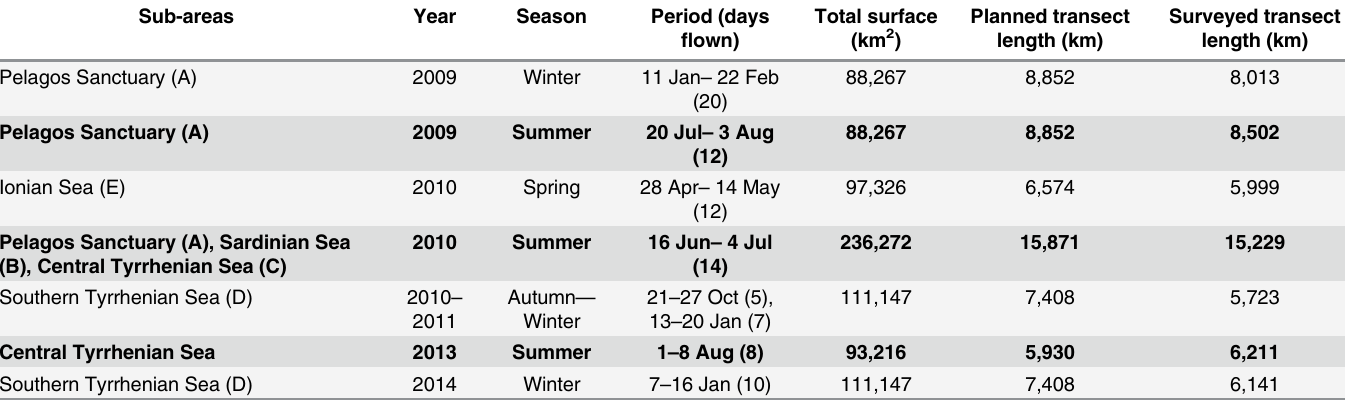
Table 1. Subareas (letters indicate corresponding sectors in Fig 1), listed in chronological order of survey timing, with subarea surfaces and tran- sect lengths (on average over 90% of the planned transect length was covered). Rows with bold lettering correspond to summer surveys, which were used for density and spatial analyses.